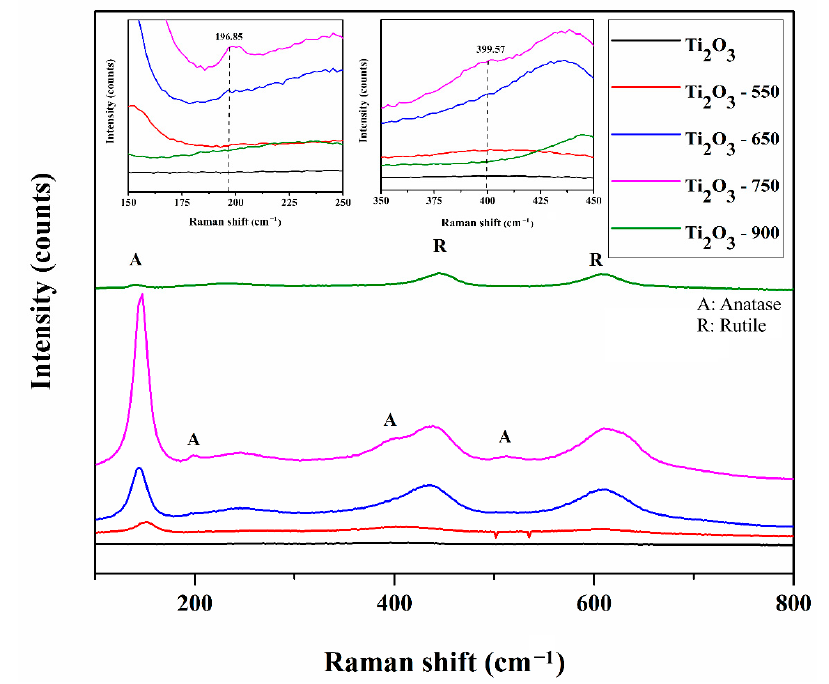
Figure 4. Raman spectra of treated Ti 2 O 3 catalysts.